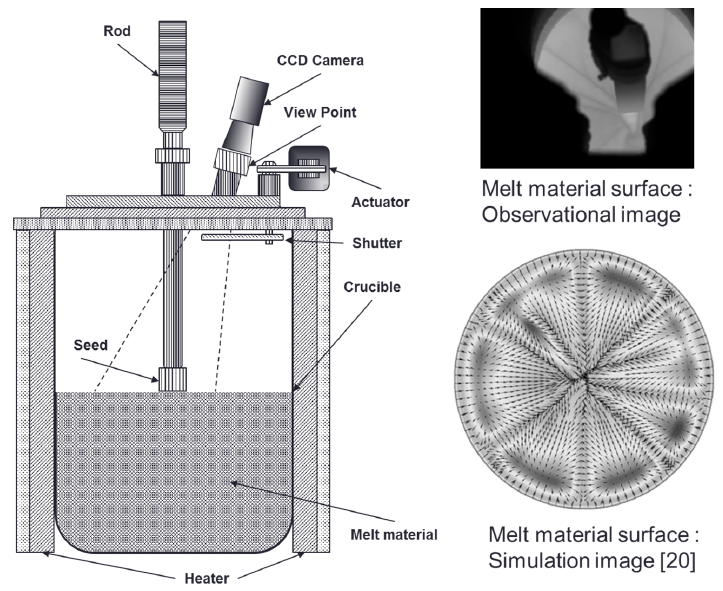
Figure 2. Comparison of the spoke pattern and observed pattern on the surface of the melt.